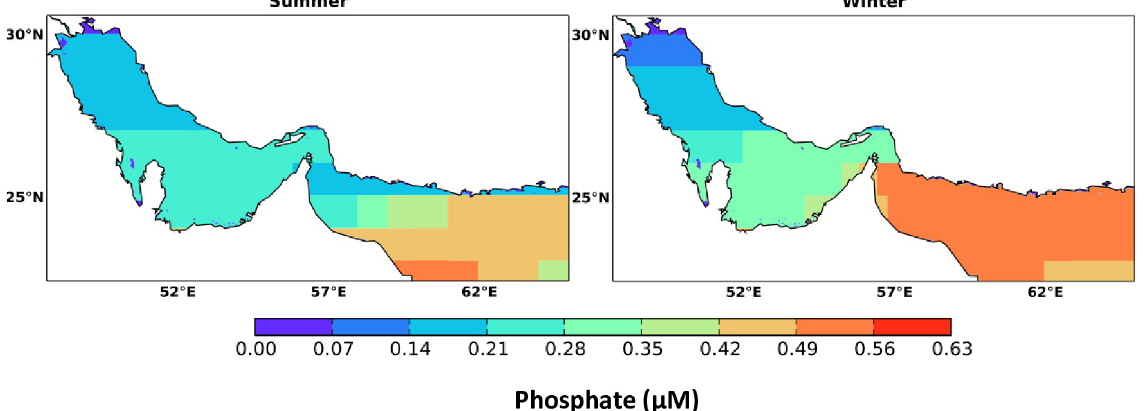
Fig 3. Seasonal spatial distribution of marine surface phosphate in the Arabian Gulf and Sea of Oman extracted from the monthly climatology of the World Ocean Atlas data (WOA) for the year 2018. The WOA data are climatological data collected from the periods